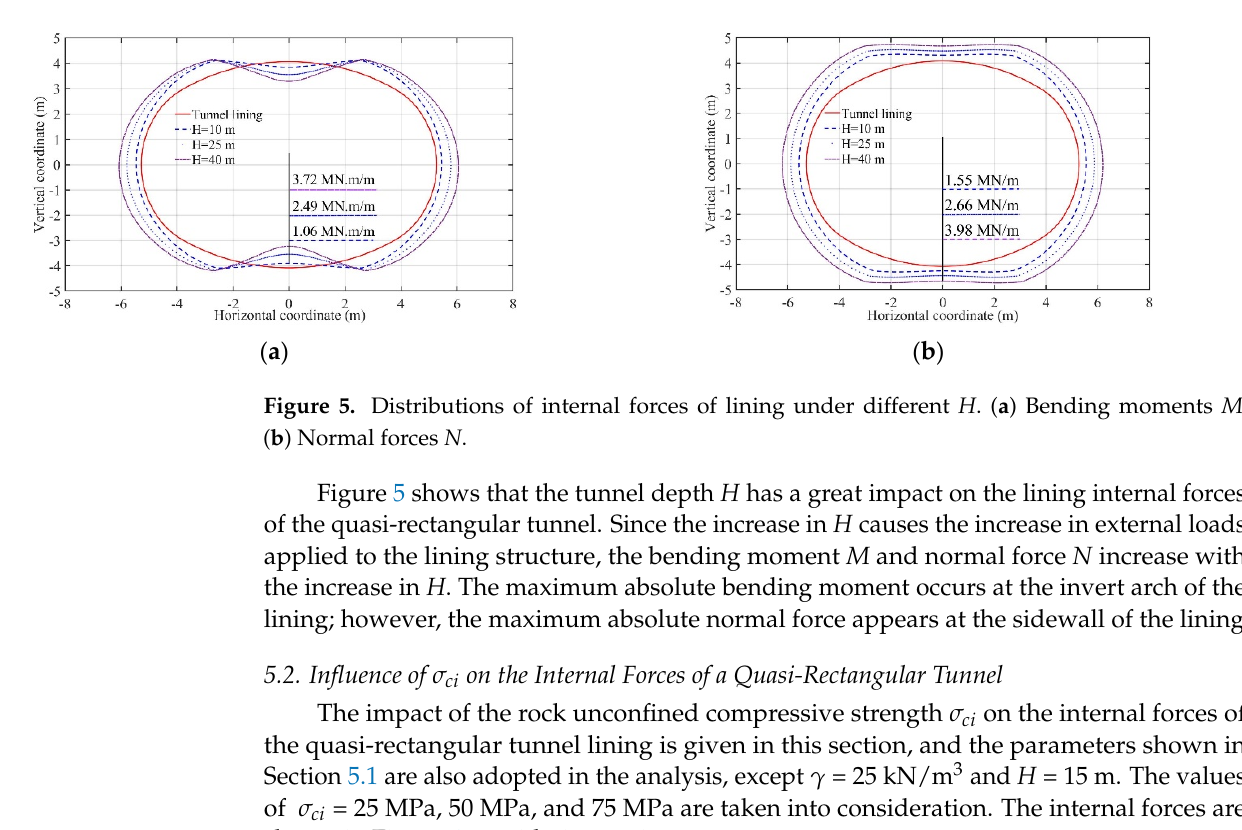
( b ) Figure 6. Distributions of internal forces of lining under different 𝜎 (cid:3030)(cid:3036) . ( a ) Bending moments M ; ( b ) Normal forces N .